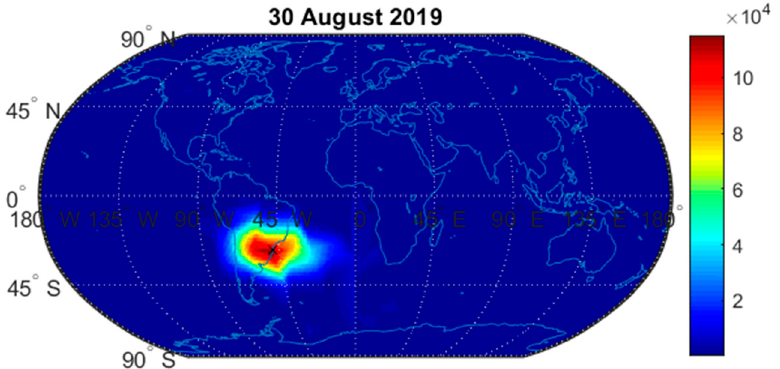
Figure 5. Example of the measurement of the radiation field (number of registered particles per minute (CMP)).